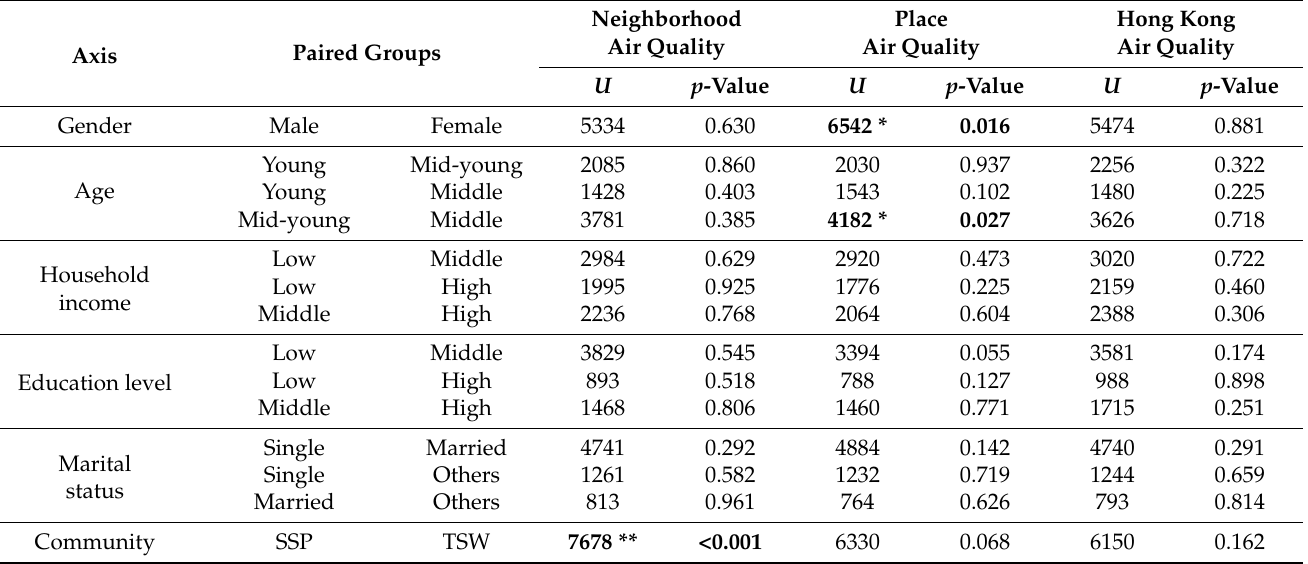
cantly not equal to 0 at the 0.01 level. All significant values are highlighted in bold font.